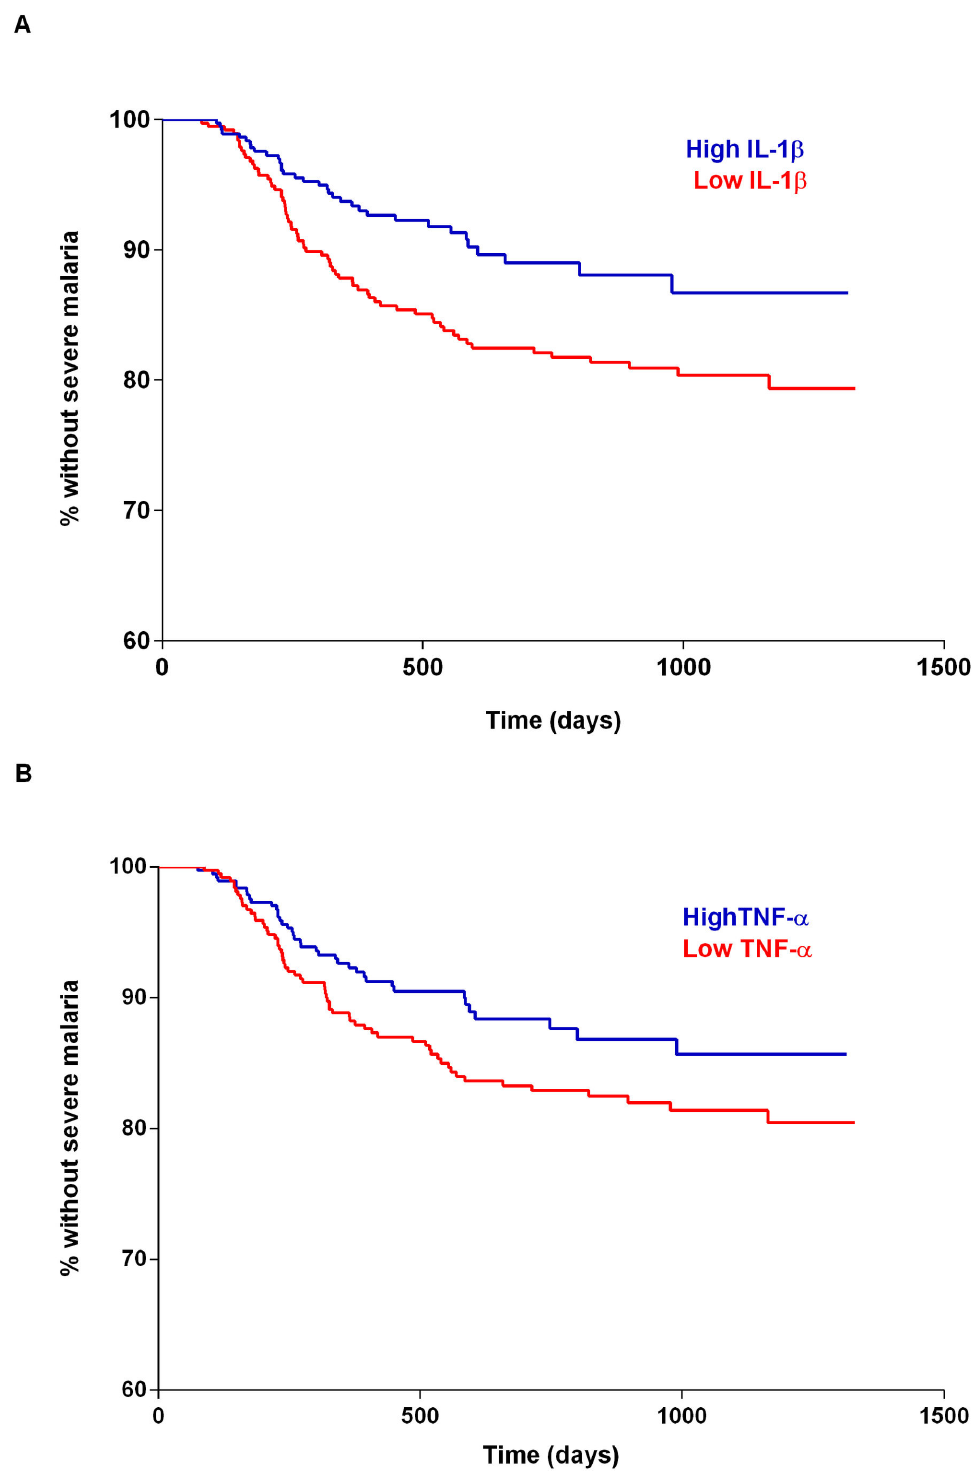
Figure 2. Kaplan-Meier curves for the risk of severe malaria. (a) High cord levels of IL-1β were associated with longer time to first severe malaria episode (P=0.008, log-rank test); (b) High levels of TNF-α at birth were marginally associated with a longer time to first severe malaria episode (P=0.08, log-rank test). High levels of cord IL-1β and TNF-α were defined based on median values (TNF-α 120.8 pg/ml; IL-1β 6 pg/ml). doi: 10.1371/journal.pone.0077214.g002 PLOS ONE |